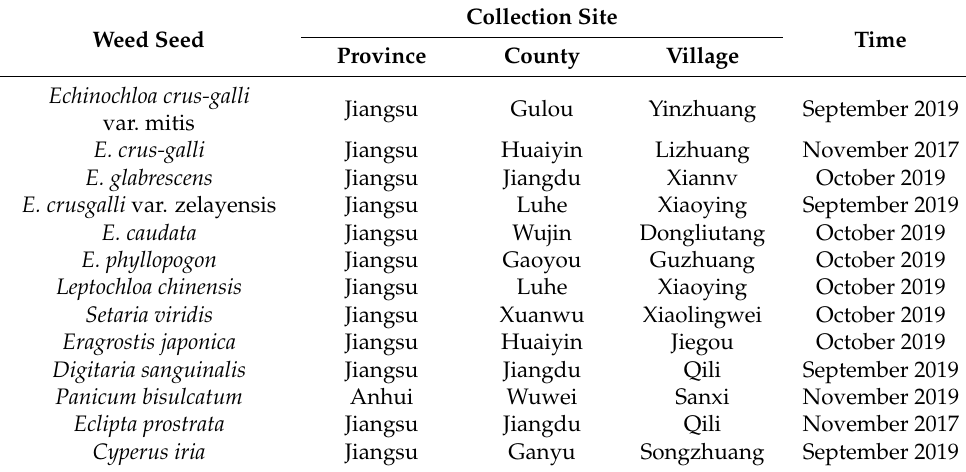
Table 1. Collection sites of tested seed populations.